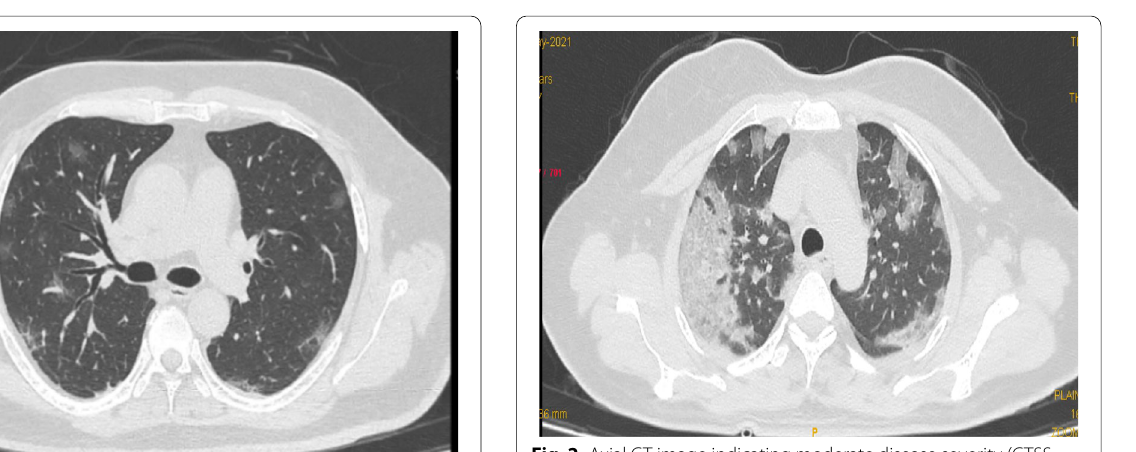
Fig. 2 Axial CT image indicating moderate disease severity (CTSS 13). Axial CT image shows GGO with septal thickening and patchy consolidation in bilateral upper and lower lobes mainly in subpleural location with CTSS